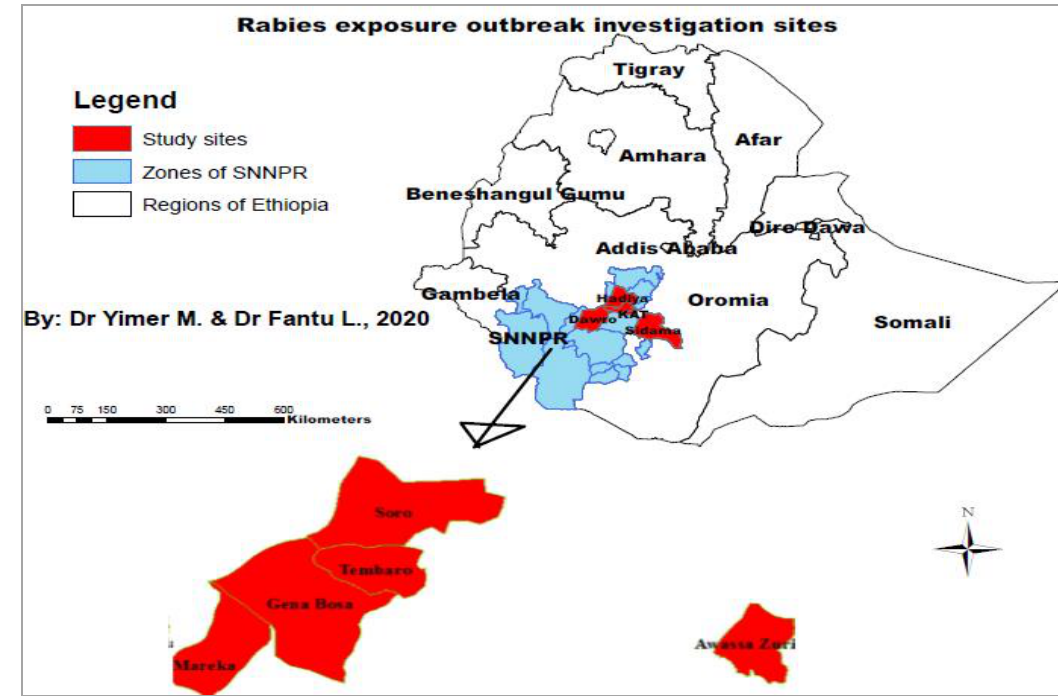
Figure 1 . Geographic location of the investigation/study